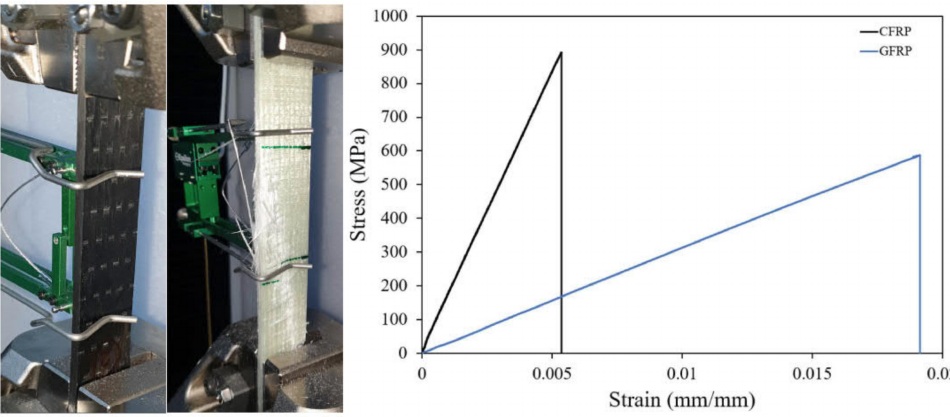
Figure 2. Test setup and experimental results of the coupon